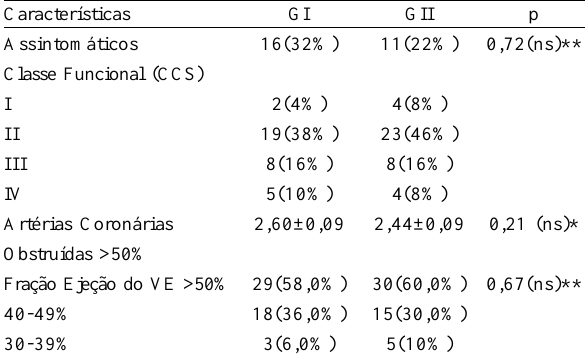
Tabela 2. Características pré-operatórias